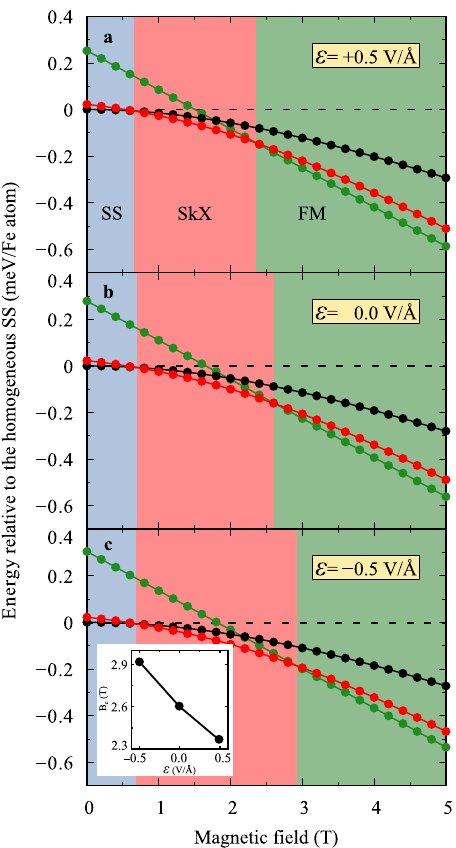
Fig. 4 Effect of electric fi elds on radius and energy barriers of isolated skyrmions. a Radius and b energy barriers of isolated Fig. 3 Effect of electric fi elds on the phase diagram. Zero skyrmions in Fe/Rh/Re(0001) with applied magnetic fi elds at E ¼ temperature phase diagram of Fe/Rh/Re(0001) at a E ¼ + 0.5 V/ Å , + 0.5 V/ Å (red), E ¼ 0 V/ Å (green), and E ¼ − 0.5 V/ Å (blue). In b E ¼ 0 V/ Å , and c E ¼ − 0.5 V/ Å . Energies of the relaxed spin spiral b , fi lled circles show collapse barriers, Δ E col , while fi lled diamonds (SS, black circles), skyrmion lattice (SkX, red circles), and fi eld- mark creation barriers, Δ E crea . Inset of a shows the skyrmion pro fi les polarized ferromagnetic (FM, green circles) states are shown with at B = 3 T for zero and two fi nite electric fi elds and b shows the reference to the homogeneous spin spiral (dashed line). The SS, SkX, variation of the critical fi eld B c (onset of FM phase) with the electric and FM phases are denoted with blue, red, and green background fi eld. Note that the critical fi eld is calculated where the energy of colors, respectively. Inset of c shows the variation of the critical fi eld isolated skyrmions is equal to the FM fi eld. Note that the critical B c (onset of FM phase) with the electric fi eld is calculated where the energy of the skyrmion lattice (SkX) phase becomes equal to the FM phase.